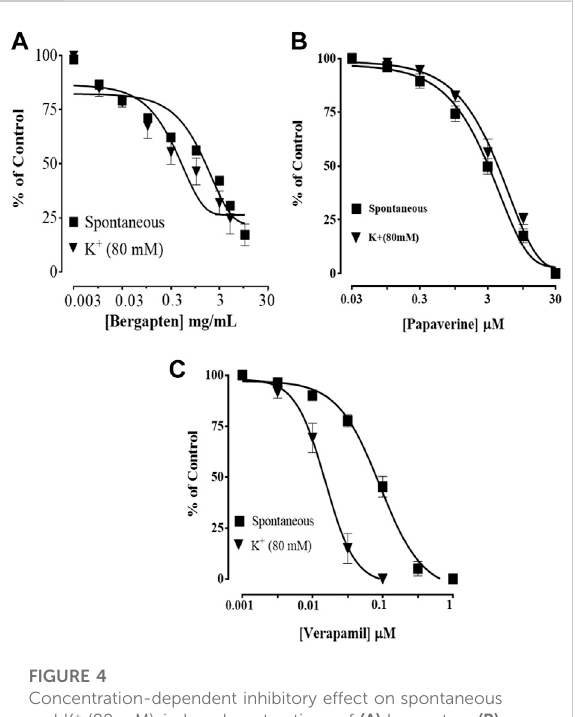
FIGURE 4 Concentration-dependent inhibitory effect on spontaneous and K + (80 mM)-induced contractions of (A) bergapten, (B) papaverine, and (C) verapamil in isolated tissue preparations. The result expressed as mean ± SEM, n = 3 – 5.